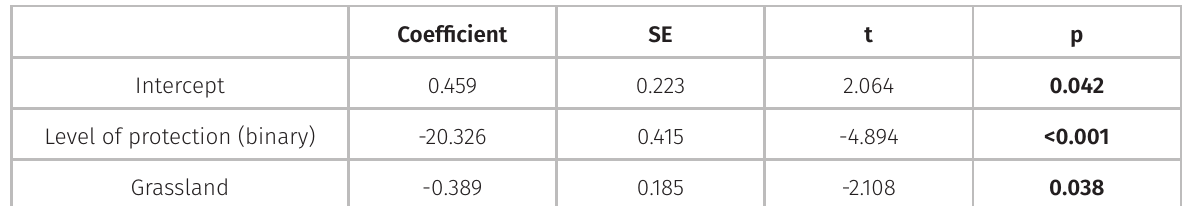
Table VI. Statistical results (coefficient estimates, standard error [SE], t value, and p-value) for the best model selected to explain roadkill events of Mammalia in the protected landscape in Alto Paraíso de Goiás, Goiás state, Brazil. Significant values at ɑ<0.05 are in